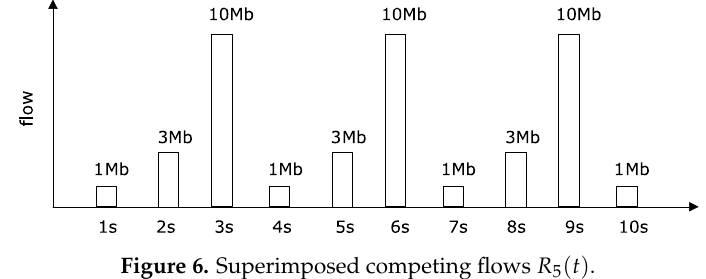
Figure 6. Superimposed competing flows 𝑅 5 (𝑡) .